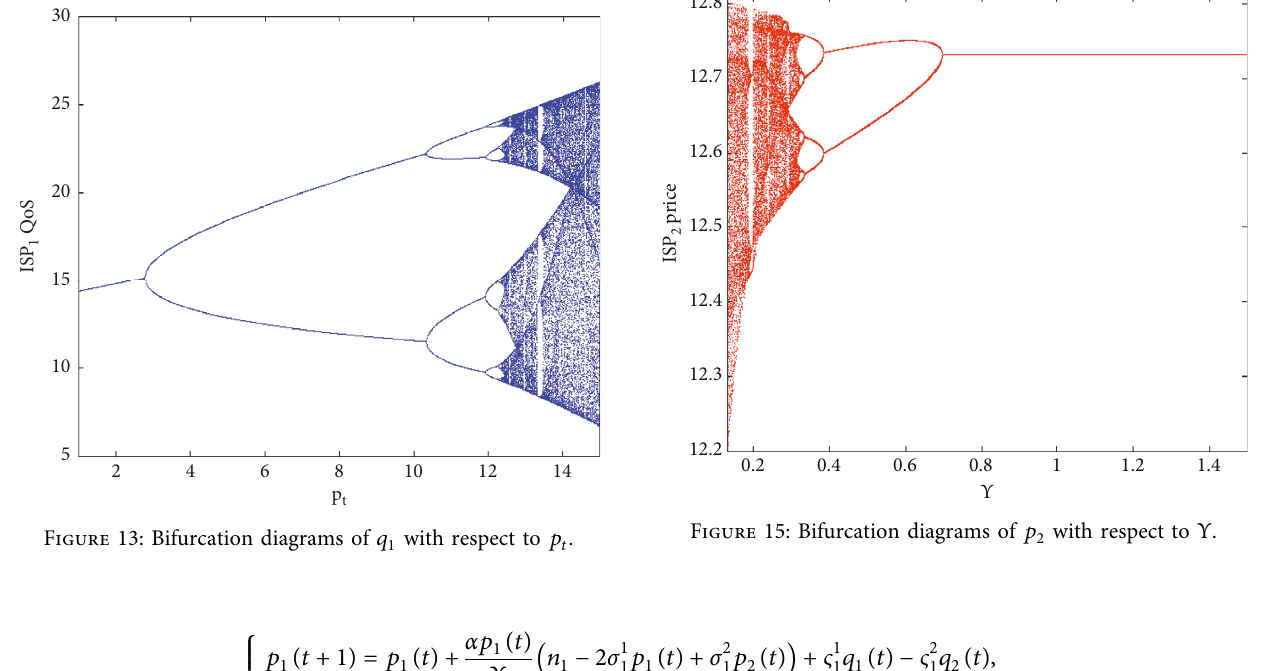
with respect to p t . 2